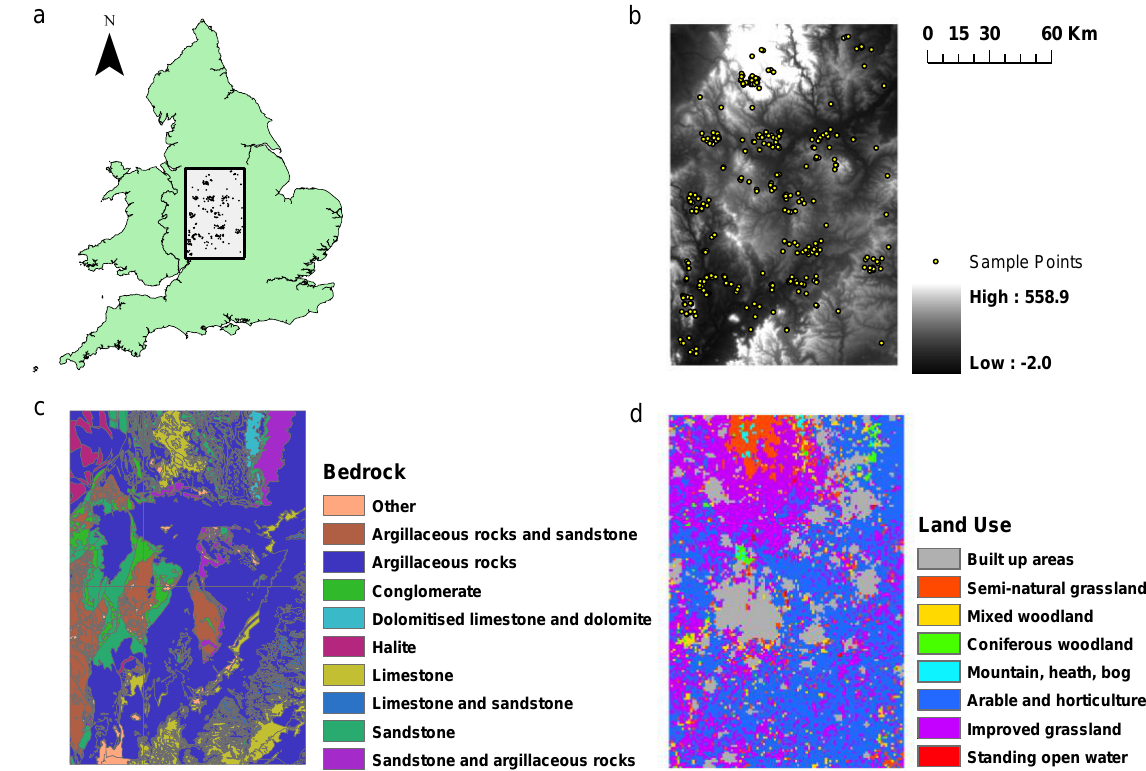
Fig. 1. Location and study area. (a) Study location in relation to England and Wales. (b) Digital elevation models and sample locations. (c) Geological rock classification scheme. (d) Dominant land use Figure 1. Location and study area. a) Study location in relation to England and Wales. b) 785 Digital elevation models and sample locations. c) Geological rock classification scheme. d) 786 Dominant land use classes. 787